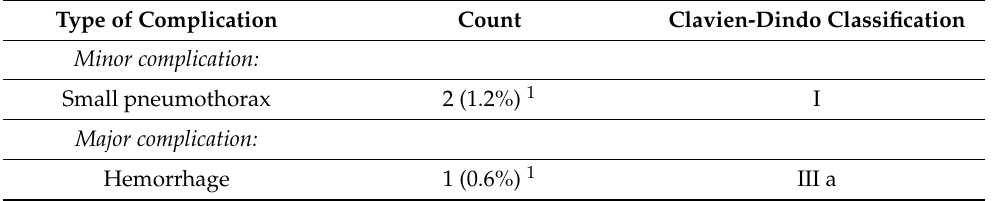
Table 4. Peri-interventional complications according to the Society of Interventional Radiology (SIR).